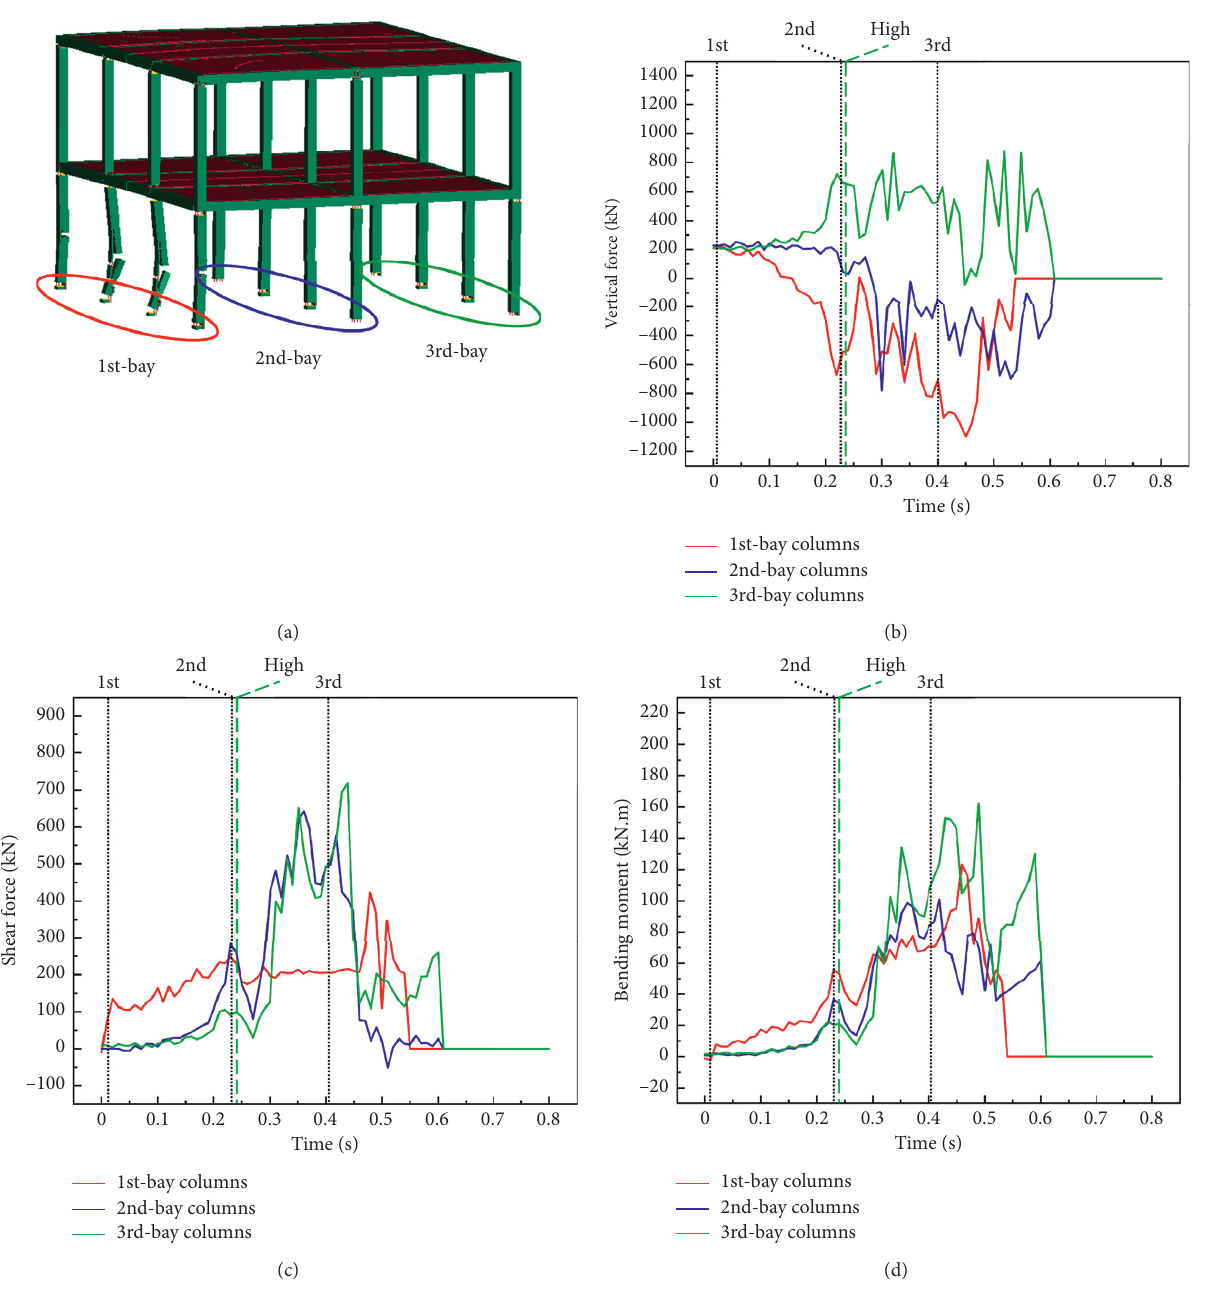
Figure 14: The comparison between the different bay columns in the scenarios of s � 1, h � 3.2m and v � 20.0 m/s: (a) vertical force, (b) shear force, and (c) bending